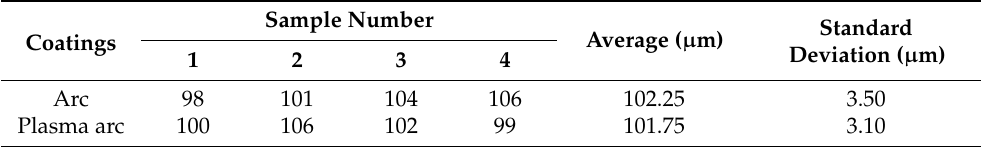
Table 2. Thickness ( µ m) of the